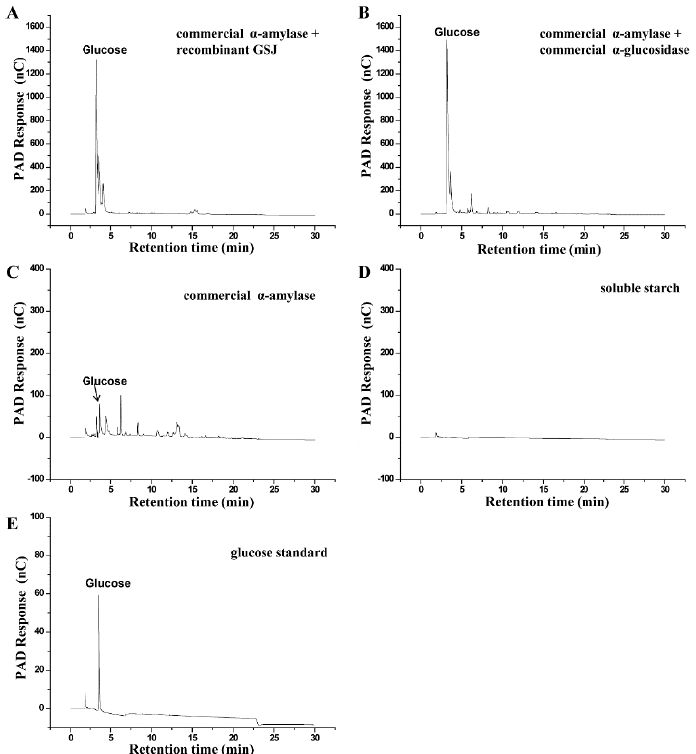
Figure 6. Identification of the hydrolysis products by HPAEC-PAD-200. The hydrolysis products of soluble starch by commercial α -amylase and recombinant GSJ ( A ), commercial α -amylase and commercial α -glucosidase ( B ), commercial α -amylase ( C ). ( D ) Soluble starch. ( E ). Standard samples of glucose.